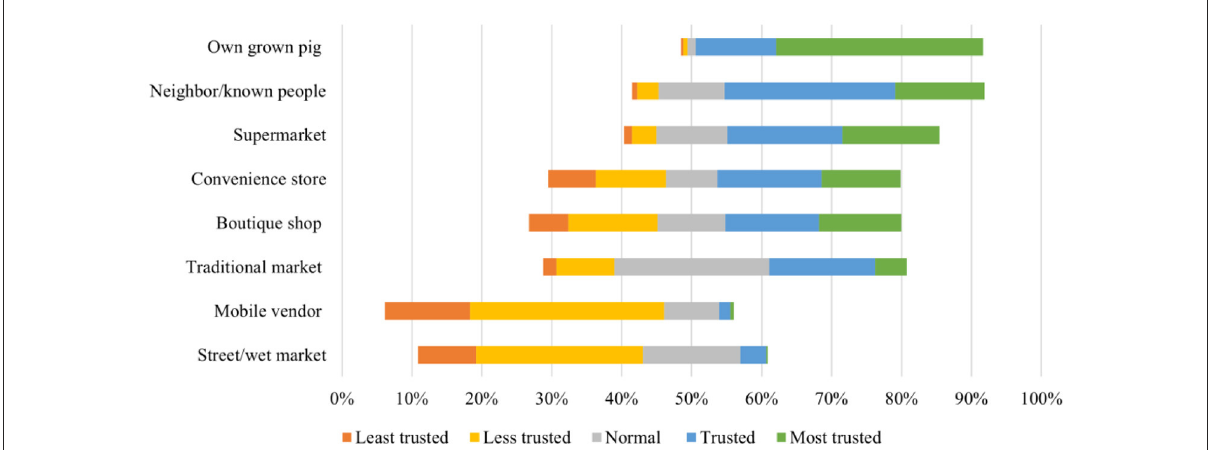
FIGURE4 Information about food safety usually heard by pork consumers from traditional rural, traditional urban and modern urban markets in Northern Vietnam in 2019 ( n = 225).